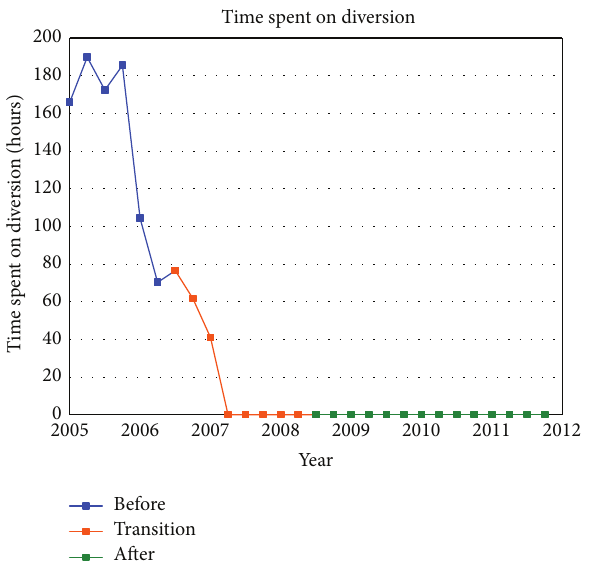
Figure 3: Quarterly patient satisfaction percentile scores based on Press Ganey